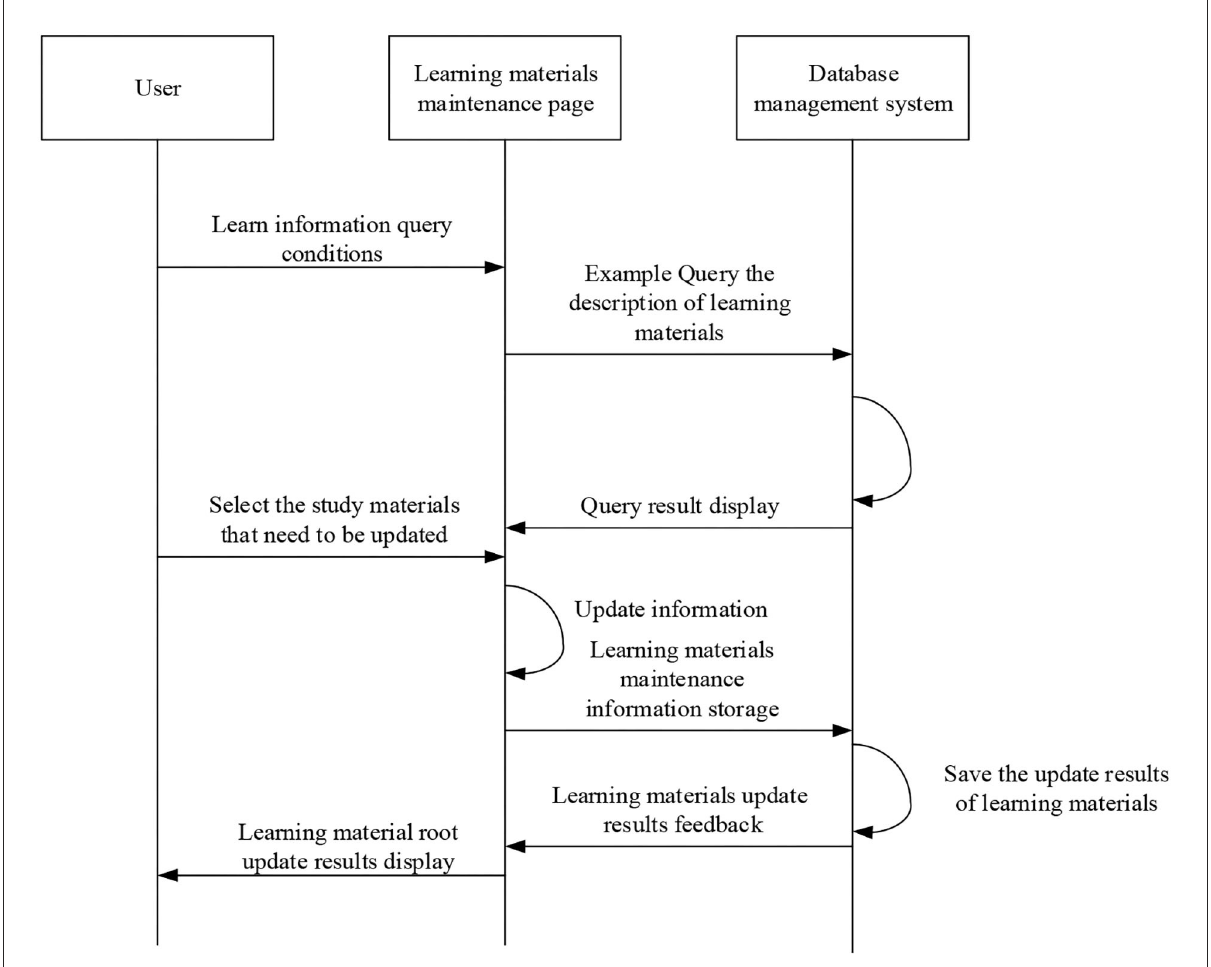
FIGURE10 Sequence diagram for the micro-video course